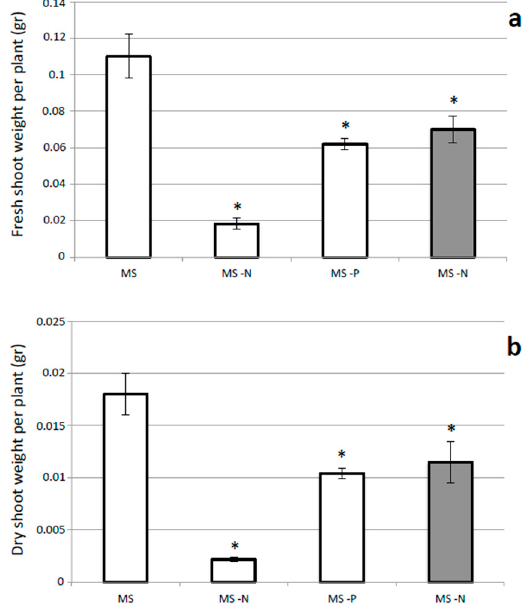
Figure 1. Quantitative analysis of growth parameters of L. japonicus plants grown in the presence/absence of N and P sources. ( a ) Fresh shoot weight per plant; ( b ) Dry shoot weight per plant. The different N and P regimes are indicated and grey bars represent values obtained after M. loti inoculation. Data bars represent means and SD of measures from three experiments (15 plants per experiment per condition). Data are scored 25 days after sowing (21 days after transferring the plants from H 2 O agar). Asterisks indicate significant differences with values scored on MS medium ( p < 0.05).